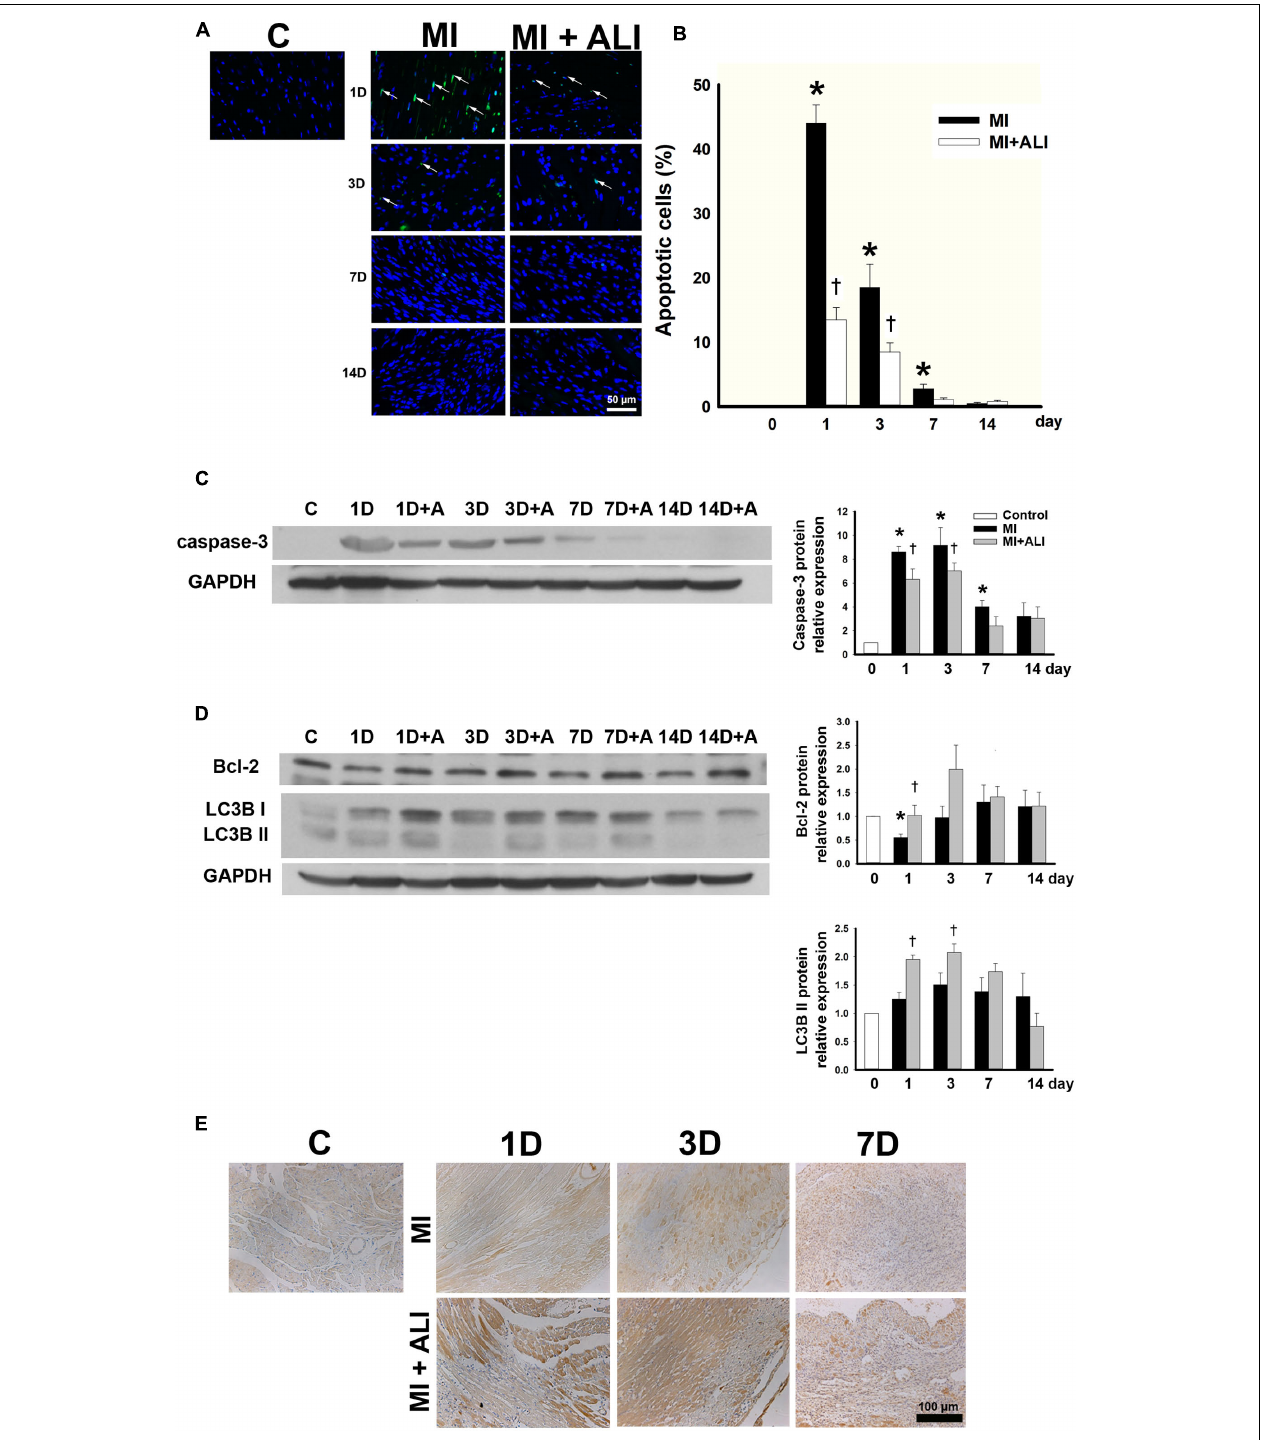
FIGURE 2 | Aliskiren adminstration strongly decreases apoptosis and increases autophagy in MI mice. (A) TUNEL staining of the infarct zone of the control, MI and MI + ALI group at the indicated time (Blue: nuclei; green: apoptotic cell). Bar = 50 µ m. (B) Apoptotic index as the percentage of TUNEL-positive nuclei compared with total nuclei. (C,D) The representative immunoblot and statistical analysis showed caspase-3 (C) , Bcl-2, and LC3B II (D) expression in cardiac samples. GAPDH was used as an internal control. (E) LC3B expression in cardiac tissues was stained by immunohistochemistry. Bar: 100 µ m. Each of the experiments was repeated three times. The data are means ± SEM. ∗ P < 0.05 compared with the control group. † P < 0.05 compared with the MI group at the indicated